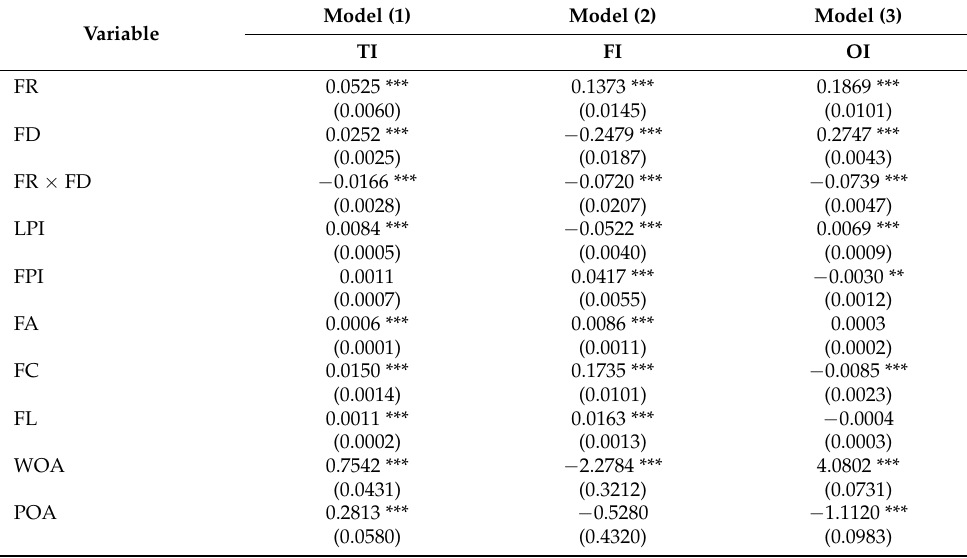
Table A3. Regulatory mechanism of farmers’